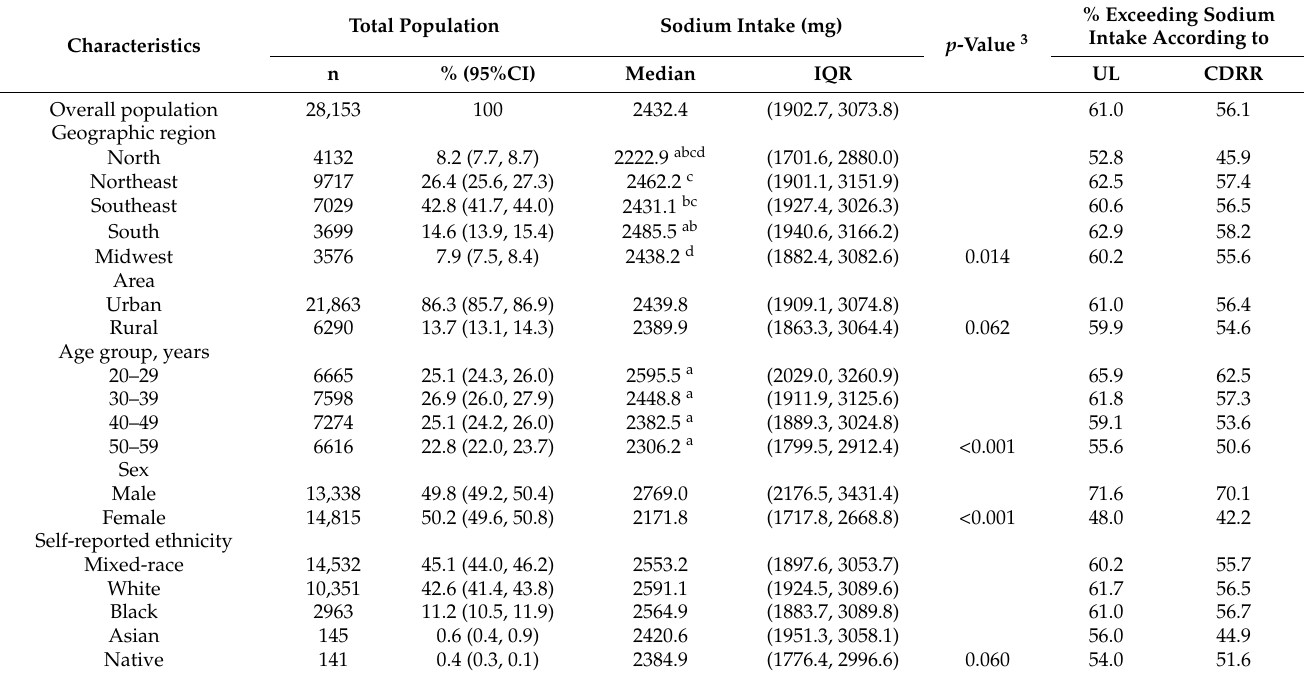
Table 1. Median sodium intake and prevalence of excessive sodium consumption according to socioeconomic, demographic, and anthropometric characteristics of the Brazilian adult population. Household Brazilian Budget Survey, 2017–2018 1